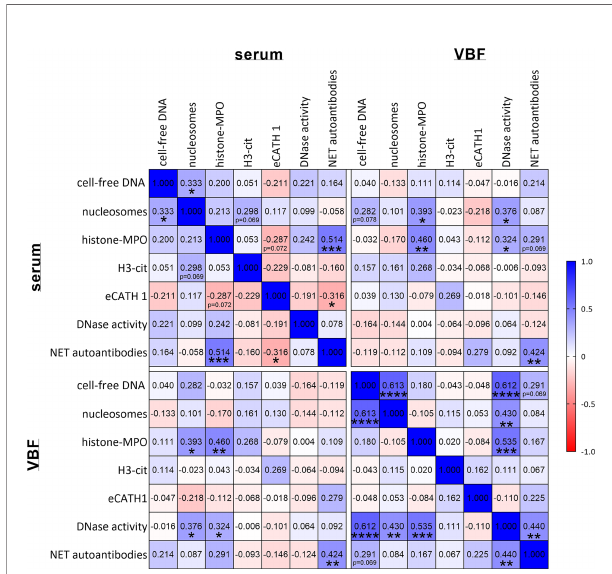
FIGURE 4 | Correlations between NET markers. Correlations between NET markers in sera and vitreous body fl uids (VBF) of 40 horses with equine recurrent uveitis (ERU) were analysed. Signi fi cant correlations between several NET markers in serum and VBF were observed. The amount of NET autoantibodies correlated signi fi cantly with histone-MPO and eCATH1 in serum as well as between serum and VBF. A two-tailed Pearson correlation was performed. Pearson ’ s r values are presented, and p values are depicted if signi fi cant ( p values of * p < 0.05, ** p < 0.01, *** p < 0.001 and **** p < 0.0001 were considered signi fi